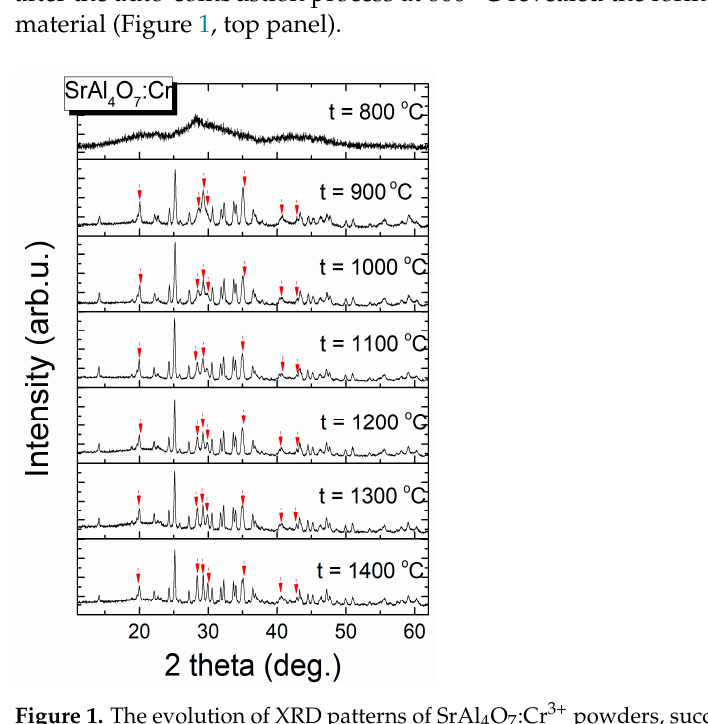
Figure 1. The evolution of XRD patterns of SrAl 4 O 7 :Cr 3+ powders, successively annealed at different temperatures. Arrows indicate extra peaks of the parasitic SrAl 2 O 4 phase.